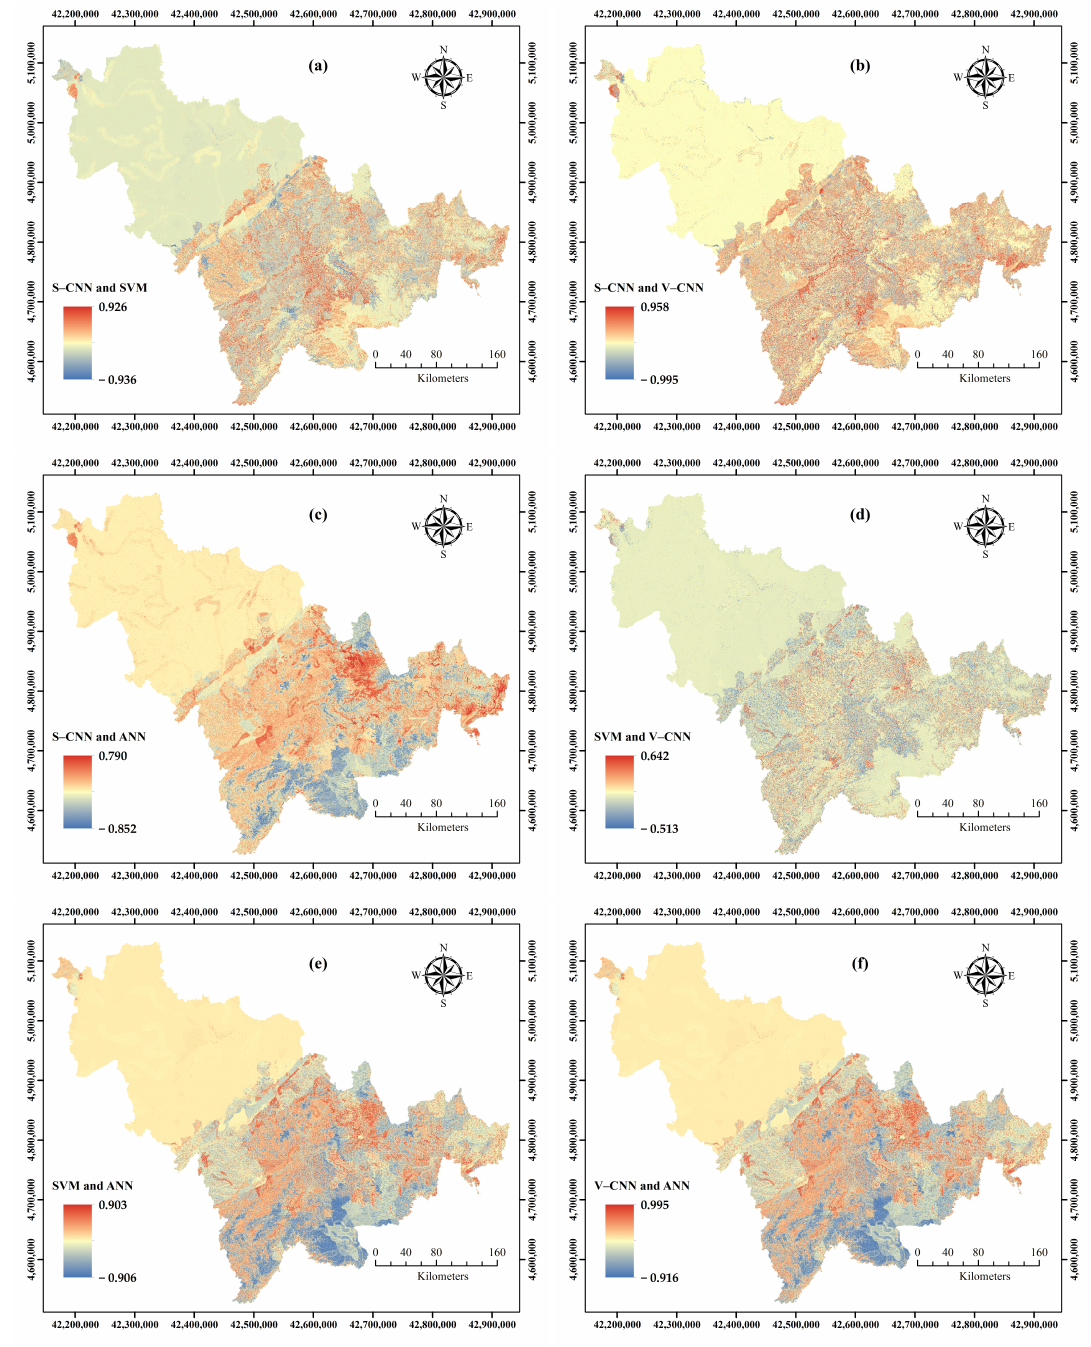
Figure 19. Comparison maps of the susceptibility values of the four models: ( a ) comparison map of S–CNN and SVM, ( b ) comparison map of S–CNN and V–CNN, ( c ) comparison map of S–CNN and ANN, ( d ) comparison map of SVM and V–CNN, ( e ) comparison map of SVM and ANN, ( f ) comparison map of V–CNN and